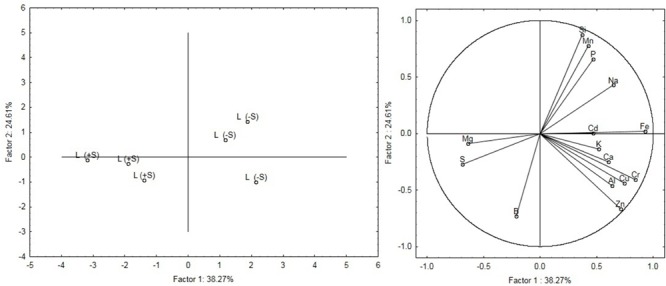
Principal components analysis (PCA) of the leaves ionome. The figure on the Left shows the modification of the leaves ionome as a function of the nutritional regime (S-deficiency and S-sufficiency). The figure on the Right shows the relationship between variables and principal components and also highlights relationships between the variables themselves.